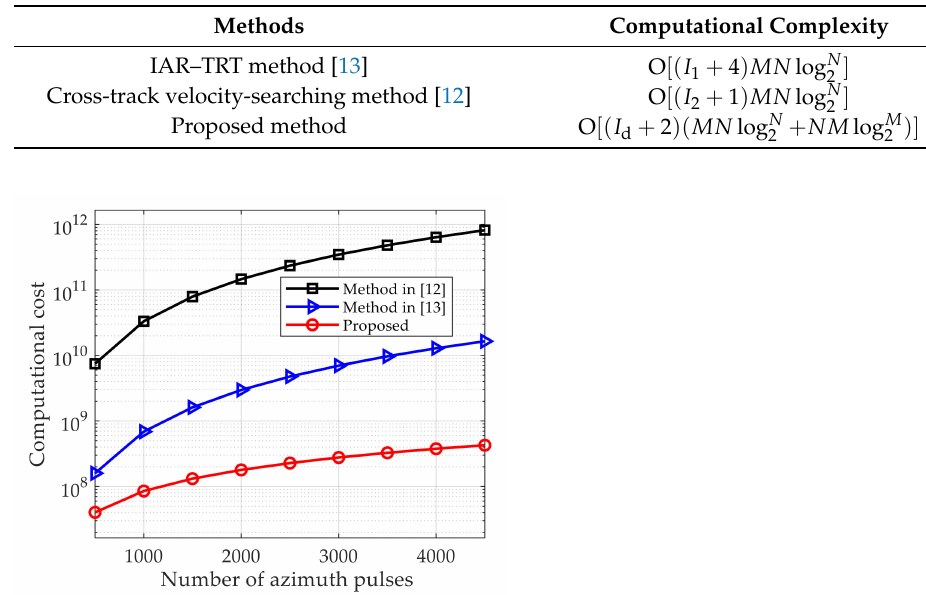
Table 5. Computational complexities of three methods.